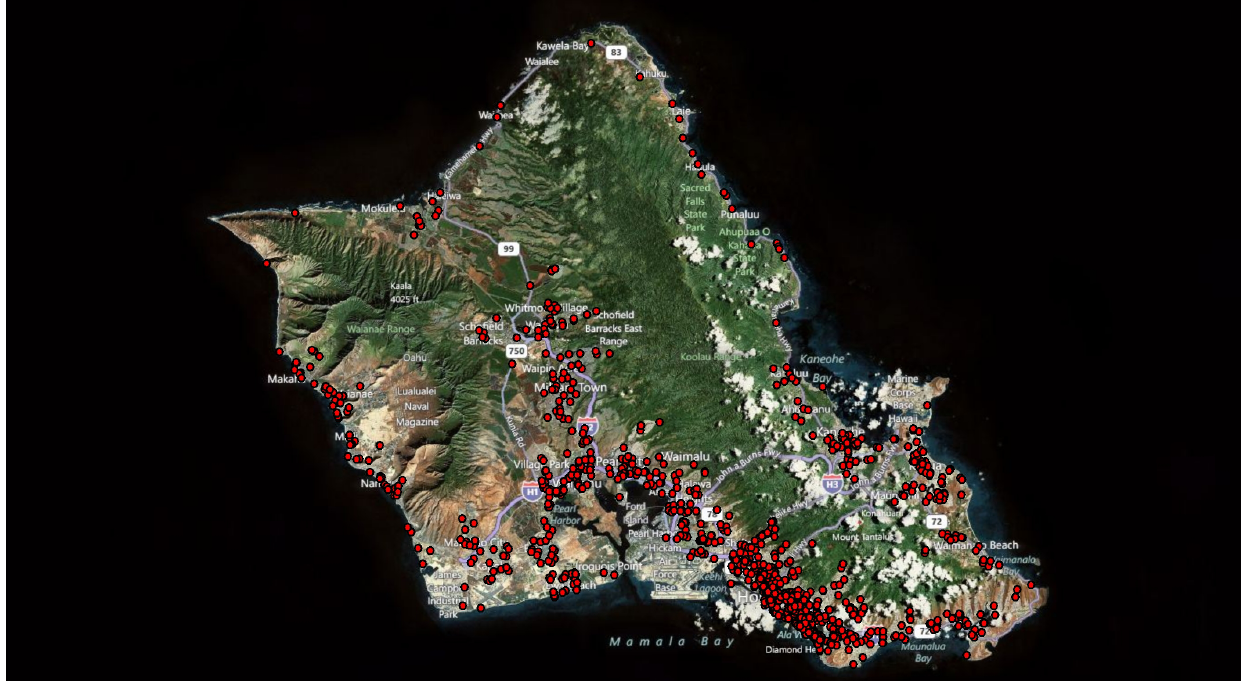
Figure 20. The geographic distribution of the 1,245 cases of the food epidemic in Oahu (year 2010).